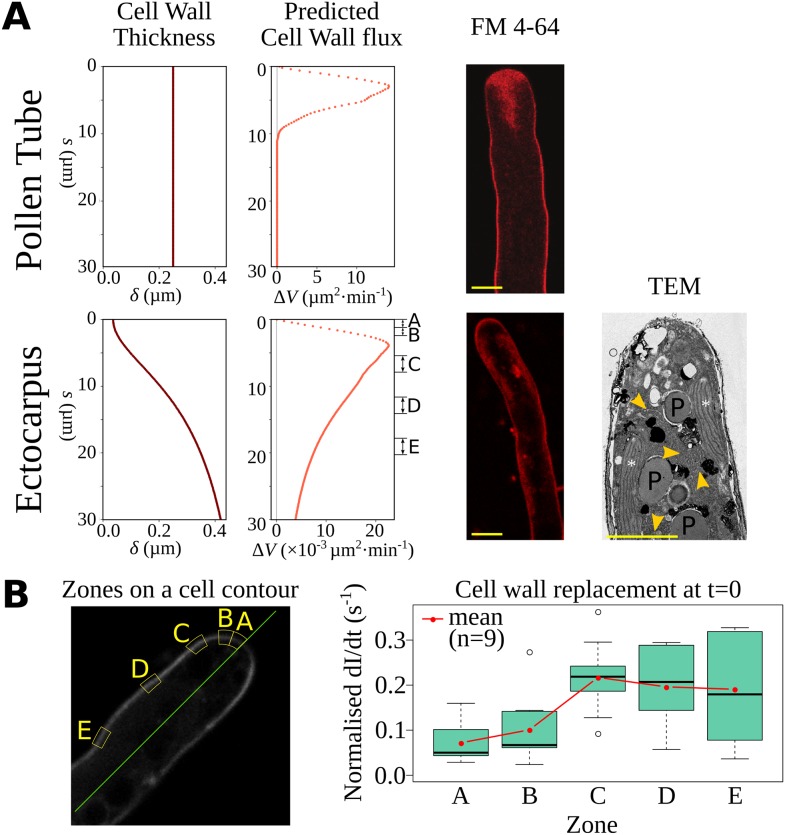
Impact of the cell wall thickness gradient and pattern of cell wall biosynthesis.(A) Dynamics of cell wall synthesis in the pollen tube (top) and Ectocarpus apical cell (bottom). From left to right: cell wall thickness δ from which the computed cell wall flux was inferred using the model. Note the different x-scales between Ectocarpus and the pollen tube. Vesicle pattern displayed by FM4-64 labeling. Confocal image about 30 min after addition of FM4-64 at RT in living Ectocarpus and in the pollen tube (Courtesy of G. Grebnev and B. Kost, Erlangen Univ., Germany). Bar = 5 μm. Longitudinal sections observed using TEM. No specific network of vesicles was observed in the dome of the Ectocarpus apical cell (see [55] for a comparative image of the pollen tube). Instead, chloroplasts and associated reticulum (see [14] for the description of the overall intracellular organization) are present all along the cell axis. White stars: chloroplasts; orange arrow heads: CER; P: pyrenoids. Bar = 5 μm. (B) FRAP experiment. (Left) Definition of the zones A–E from which fluorescence recovery was measured (also shown in panel A). (Right) Quantification of cell wall replacement expressed as the increase in normalized fluorescence intensity at t = 0 (time of photobleaching). See S7 Fig for details about the FRAP analysis. Data are available as S8 Data. CER, chloroplastic endoplasmic reticulum; FRAP, fluorescence recovery after photobleaching; RT, room temperature; TEM, transmission electron microscopy.